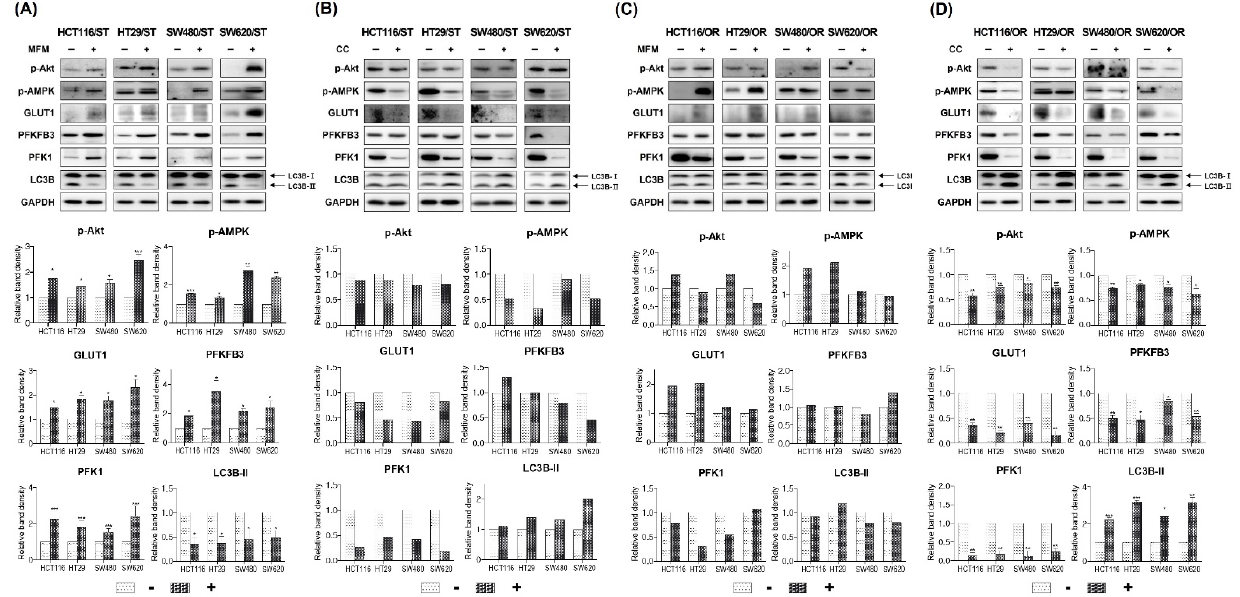
Figure 9. Effects of AMPK on the protein expression involved in glycolysis and autophagy in HCT116, HT29, SW480 and SW620 colorectal cancer (CRC) cells by treating metformin as an AMPK activator or compound C as an AMPK inhibitor. ( A ) Parental (PT) CRC cells were pretreated with or without 20 mM metformin followed by 2.5 µM oxaliplatin for 24 h. ( B ) Parental (PT) CRC cells were pretreated with or without 10 µM compound C followed by 2.5 µM oxaliplatin for 24 h. ( C ) Oxaliplatin resistant (OR) CRC cells were pretreated with or without 20 mM metformin followed by 2.5 µM oxaliplatin for 24 h. ( D ) Oxaliplatin resistant (OR) CRC cells were pretreated with or without 10 µM compound C followed by 2.5 µM oxaliplatin for 24 h. Protein expression was determined by immunoblot analysis. Graphical analysis of band intensities normalized for protein loading with GAPDH. Columns and error bars represent means ± standards deviation of immunoblot band intensities of 3 separate protein preparations. * p < 0.05; ** p < 0.01; *** p < 0.001. p-, phospho-; GLUT1, glucose transporter 1; AMPK, AMP-activated protein kinase; PFK1, phosphofructokinase 1; PFKFB3, 6-phosphofructo-2-kinase/fructose-2,6-biphosphatase 3; GAPDH, glyceraldehyde 3-phosphate dehydrogenase; MFM, metformin; CC, compound C.